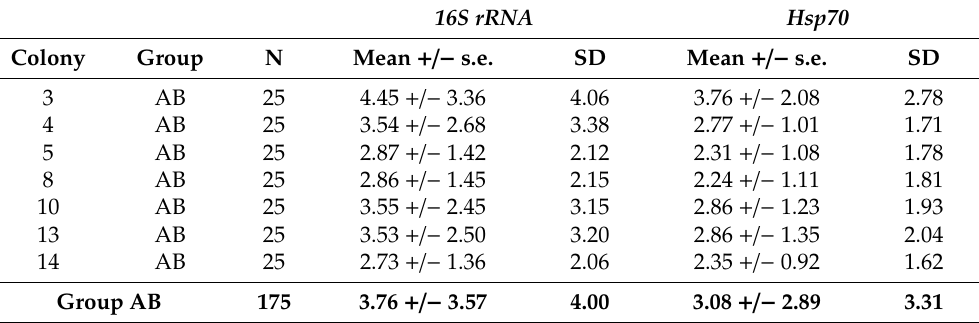
Table 3. Post-treatment abundance detected at the colony level (for details, see Table 2). As a treatment e ff ect could be detected, the group means are shown also. Some AH colonies resulted as negative (i.e., zero N. ceranae copies / bee), which precluded the transformation into logarithms. Those cases are indicated with an asterisk and represent a non-significant ( 16S rRNA ( χ 2 (1, N = 19) = 2.287, p = 0.319)) and, respectively, significant ( Hsp70 ( χ 2 (1, N = 19) = 7.719, p = 0.021)) proportion of colonies that became negative. 16S rRNA Hsp70 Colony Group N Mean +/ −